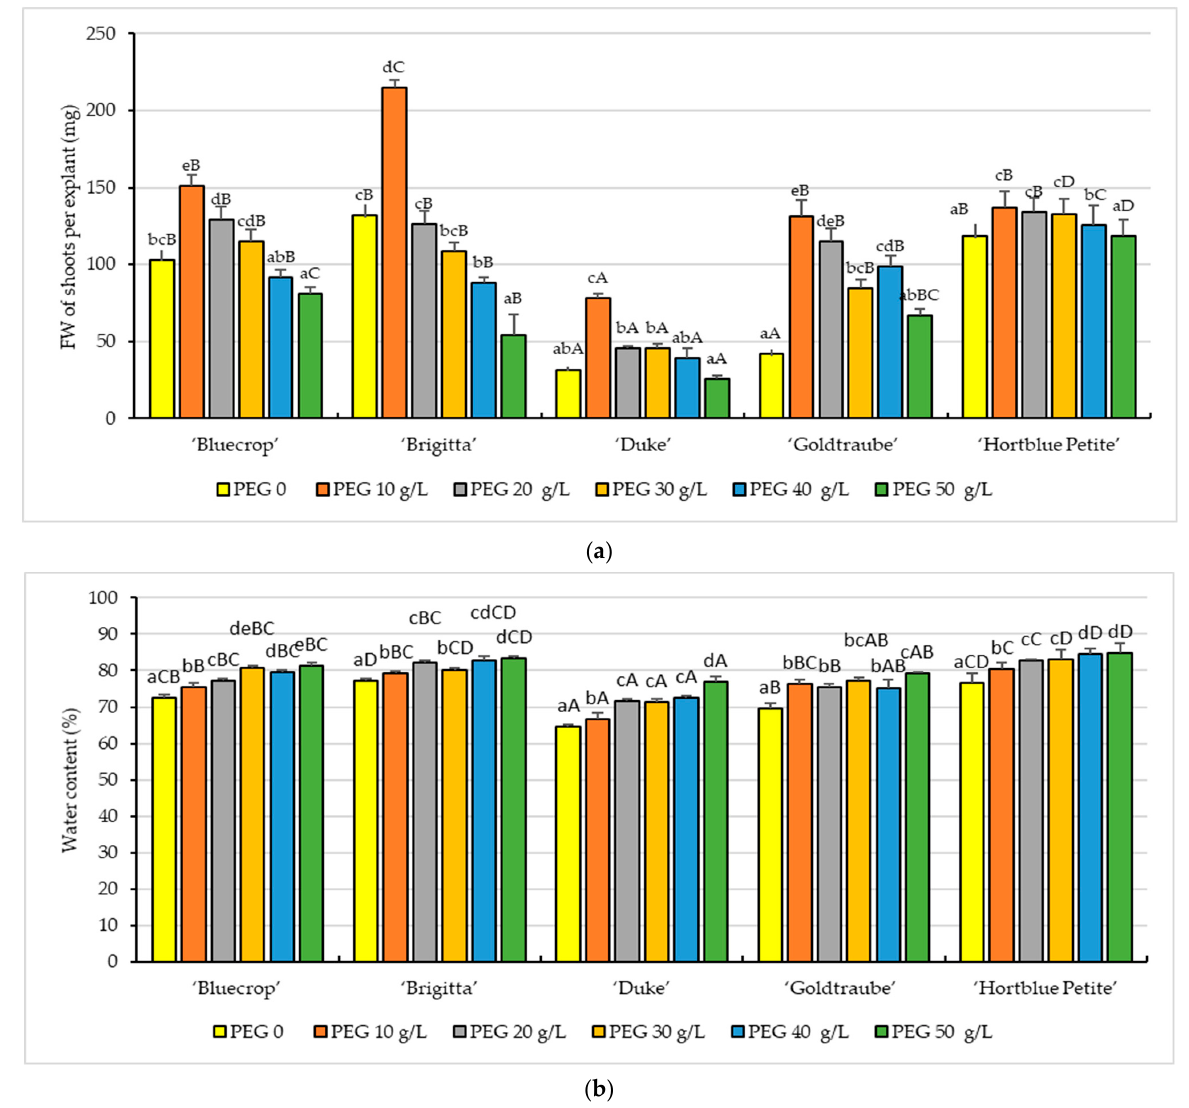
Figure 3. Effects of drought stress on ( a ) fresh weight (FW), ( b ) water content (WC) of five in vitro- grown highbush blueberry cultivars (Bluecrop, Brigitta Blue, Duke, Goldtraube and Hortblue Petite). For inducing the drought stress in culture media [Woody Plant Medium (WPM) + 100 mg/L Se- questren 138 + 1 mg/L zeatin (Z) + 4 g/L Plant agar, pH = 5] were added different concentrations polyethylene glycol (PEG 6000) (0 g/L, 10 g/L, 20 g/L, 30 g/L, 40 g/L, 50 g/L). Error bars indi- cate mean ± SE, and different lowercase letters within each cultivar indicate significant differences among the treatments and different capital letters indicate significant differences among the cultivars undergoing the same treatment according to Tukey’s HSD test ( p <